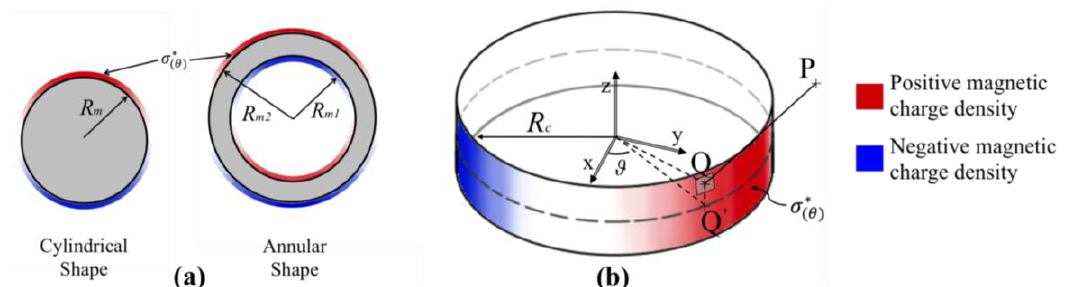
Figure 1. ( a ) Scheme of the distribution of the equivalent magnetic charge on the cylindrical surfaces of the cylindrical and annular magnets; ( b ) scheme of the geometry of the model employed for the